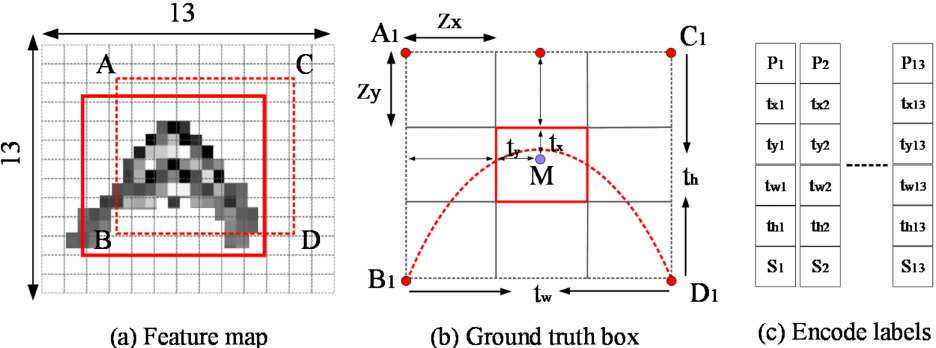
Figure 3. Improved YOLO v3 bounding box encoding: ( a ) Feature map of GPR target in YOLO v3; ( b ) Ground truth box of hyperbolic signal; ( c ) Encoding format of detecting GPR